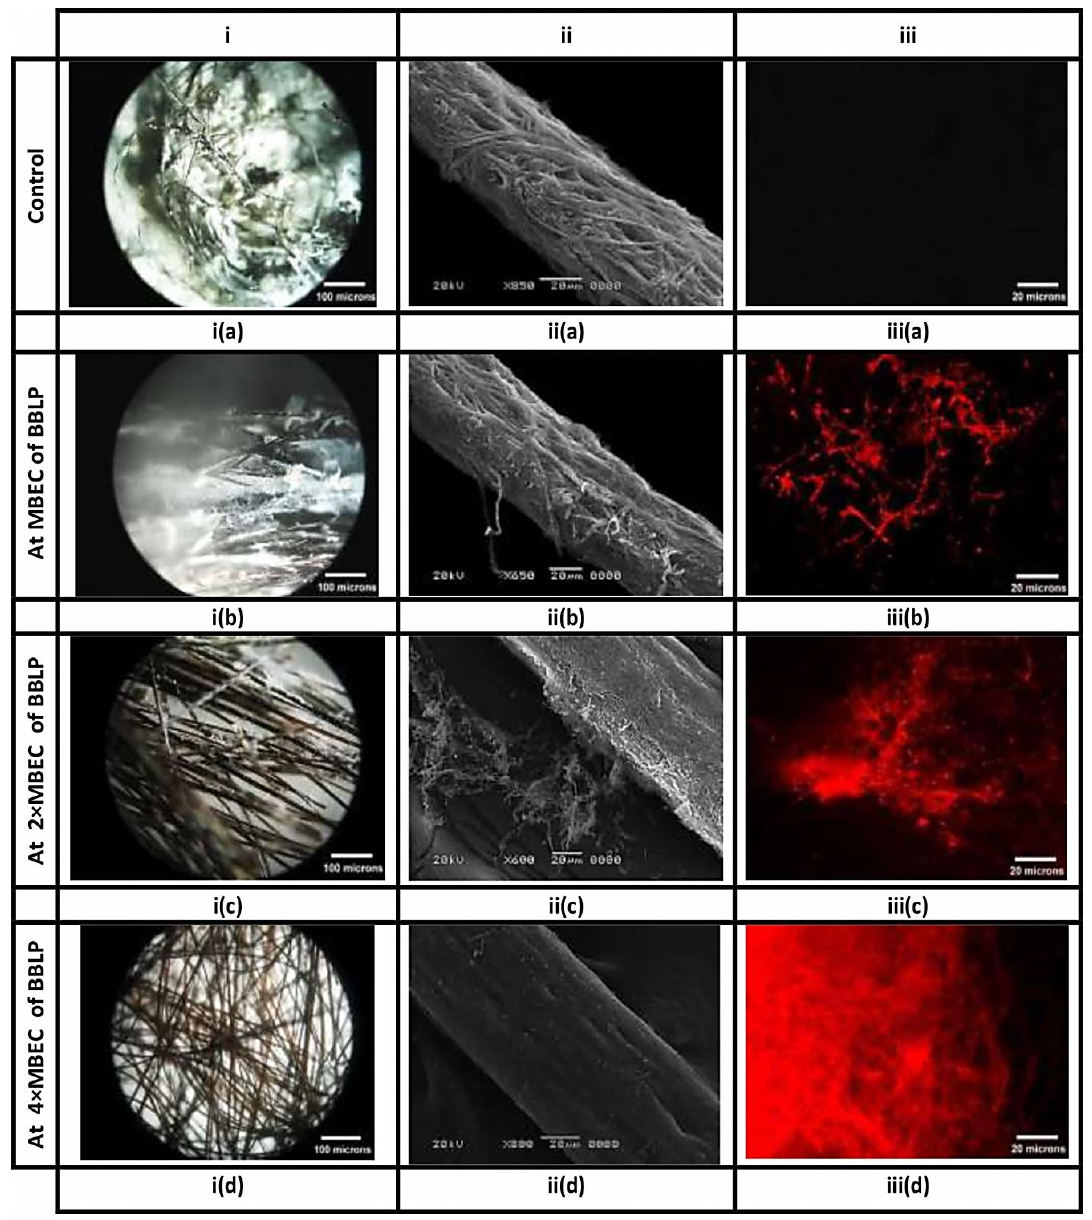
Figure 6. Biofilms of M. canis , formed on hair fragments, are visualized by different microscopic techniques. Columns (i), (ii) and (iii) correspond to stereo, scanning electron, and fluorescence images, respectively. Columns i and ii provide an overview and close up inspection of M. canis ex vivo biofilms, respectively, indicating the obliteration of the fungal elements, as they affected by BBLP in a dose-dependent manner (ia-iia, ib-iib, ic-iic, and id-iid, respectively) compared to the untreated controls (ia-iia) respectively. On the other hand, Column (iii) provides the appearance of red hyphae in an ascending order (iiib < iiic < iiid, respectively) indicating that the integrity of the cell membrane had been compromised as compared to the intact control without red hyphae (iiia).